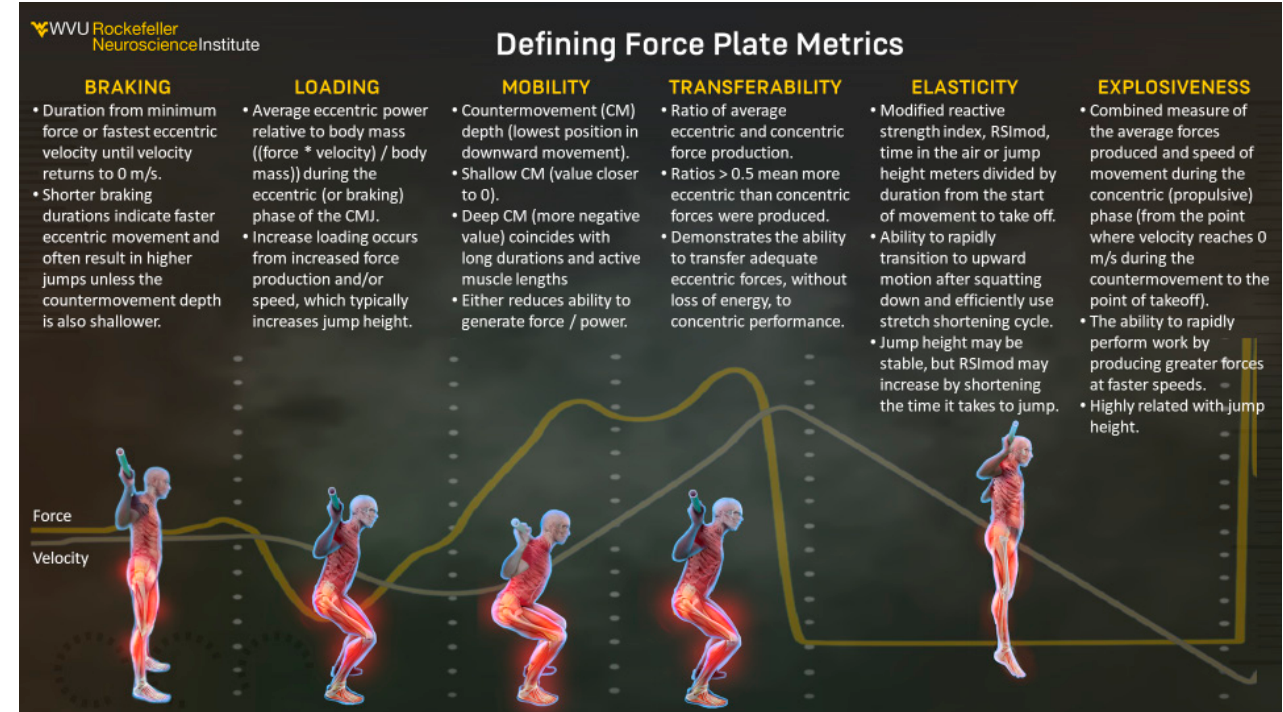
Figure 5. Definitions of Variables of Emphasis in the force-time curve.